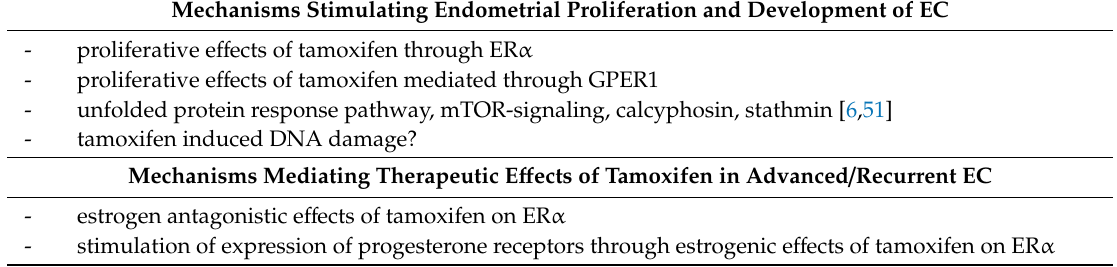
Table 1. Proposed molecular mechanisms (selection) of tamoxifen in endometrium and endometrial (pre-) cancer